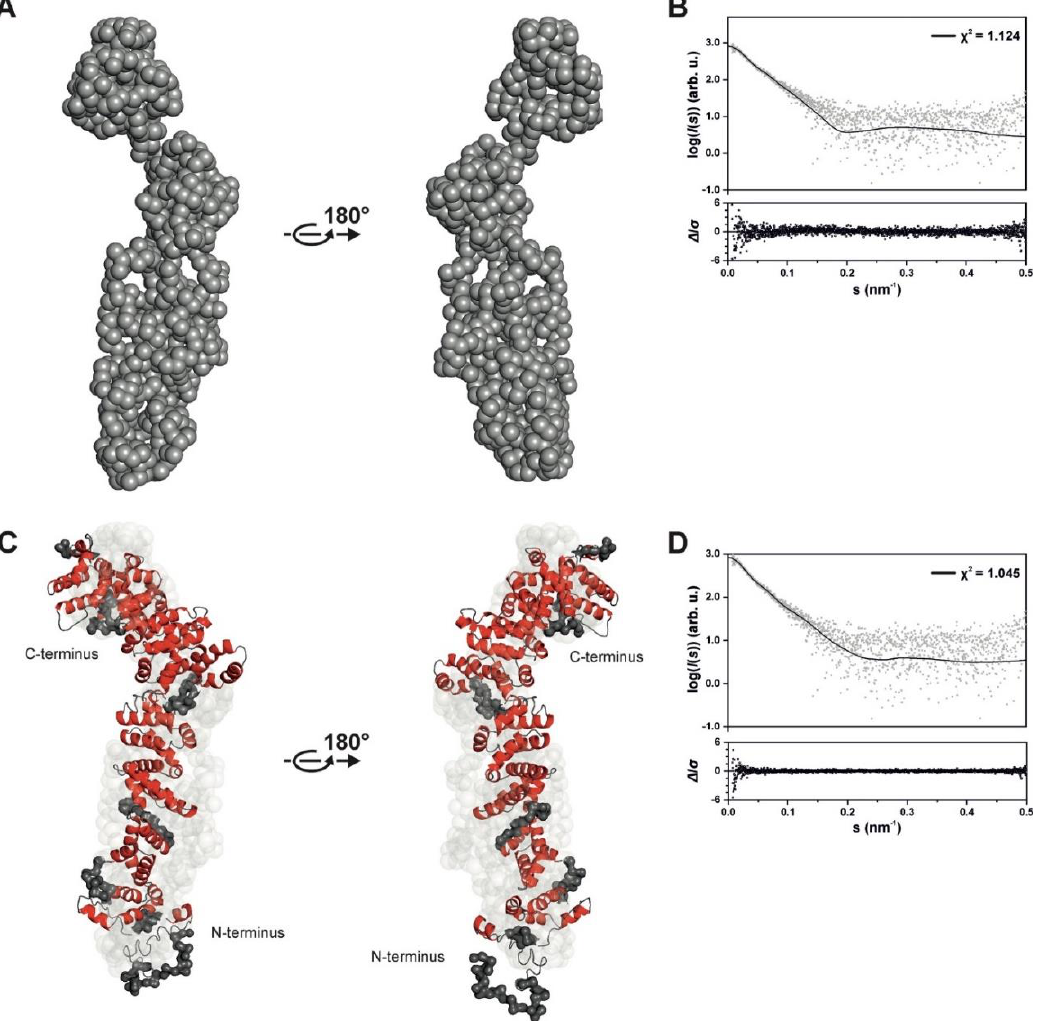
Figure 3. Ab initio and in silico structures of SAUL1 derived from SEC-SAXS measurements. ( A ) Ab initio bead model of SAUL1 with a resolution of 45 ± 3 Å and normalized spatial discrepancy of 1.498. ( B ) Fit of the ab initio model to the raw scattering data with the standardized residual plot Δ/σ = ( I exp ( s ) - I mod ( s ))/ σ ( s ). ( C ) I-TASSER derived in silico model, subdivided into different domains upon an InterPro analysis and refined using EOM . Depicted are α-helices (red), β-sheets (blue), loops (gray), and flexible regions (gray). ( D ) Fit of the in silico model to the raw scattering data with the standardized residual plot.